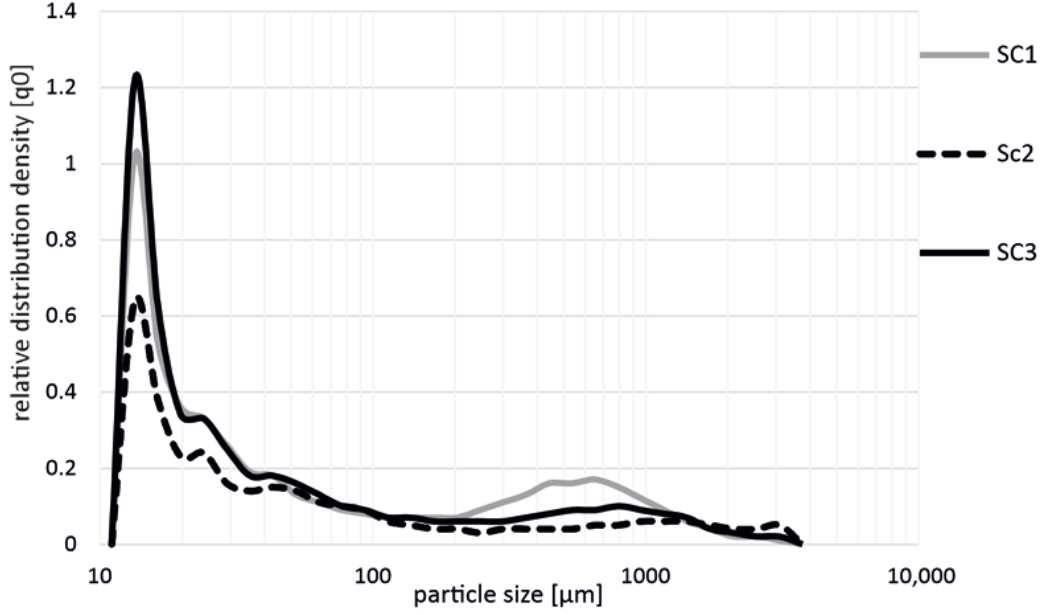
Figure 3. Influence on fiber length during the production of PP GF 30 with different screw configu- rations (SC1, SC2, SC3) in the extrusion process.